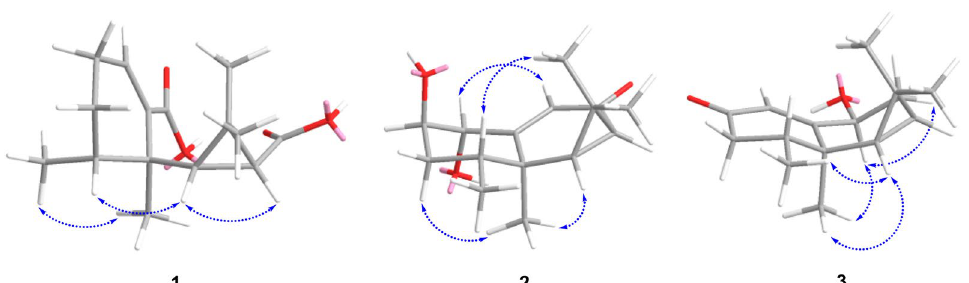
H O (calcd. for 15 22 4